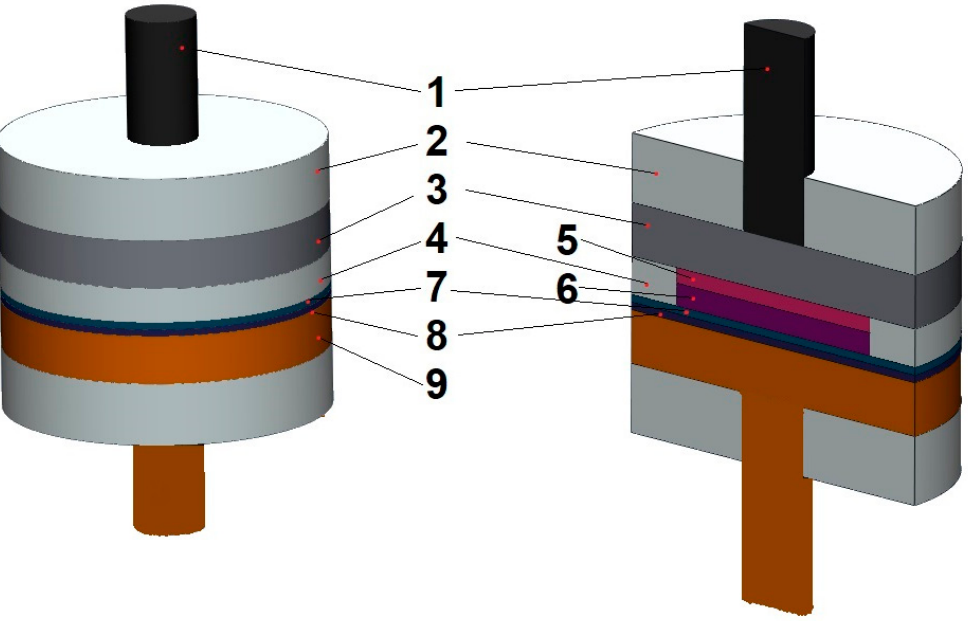
Figure 1. The scheme of two-electrode cell: 1—carbon current collector, 2—fluoroplastic ring, 3—graphite, 4—silicone ring, 5—graphite foil, 6—activated carbon fiber CH-900-20, 7—membrane, 8—separator, 9—Zn.